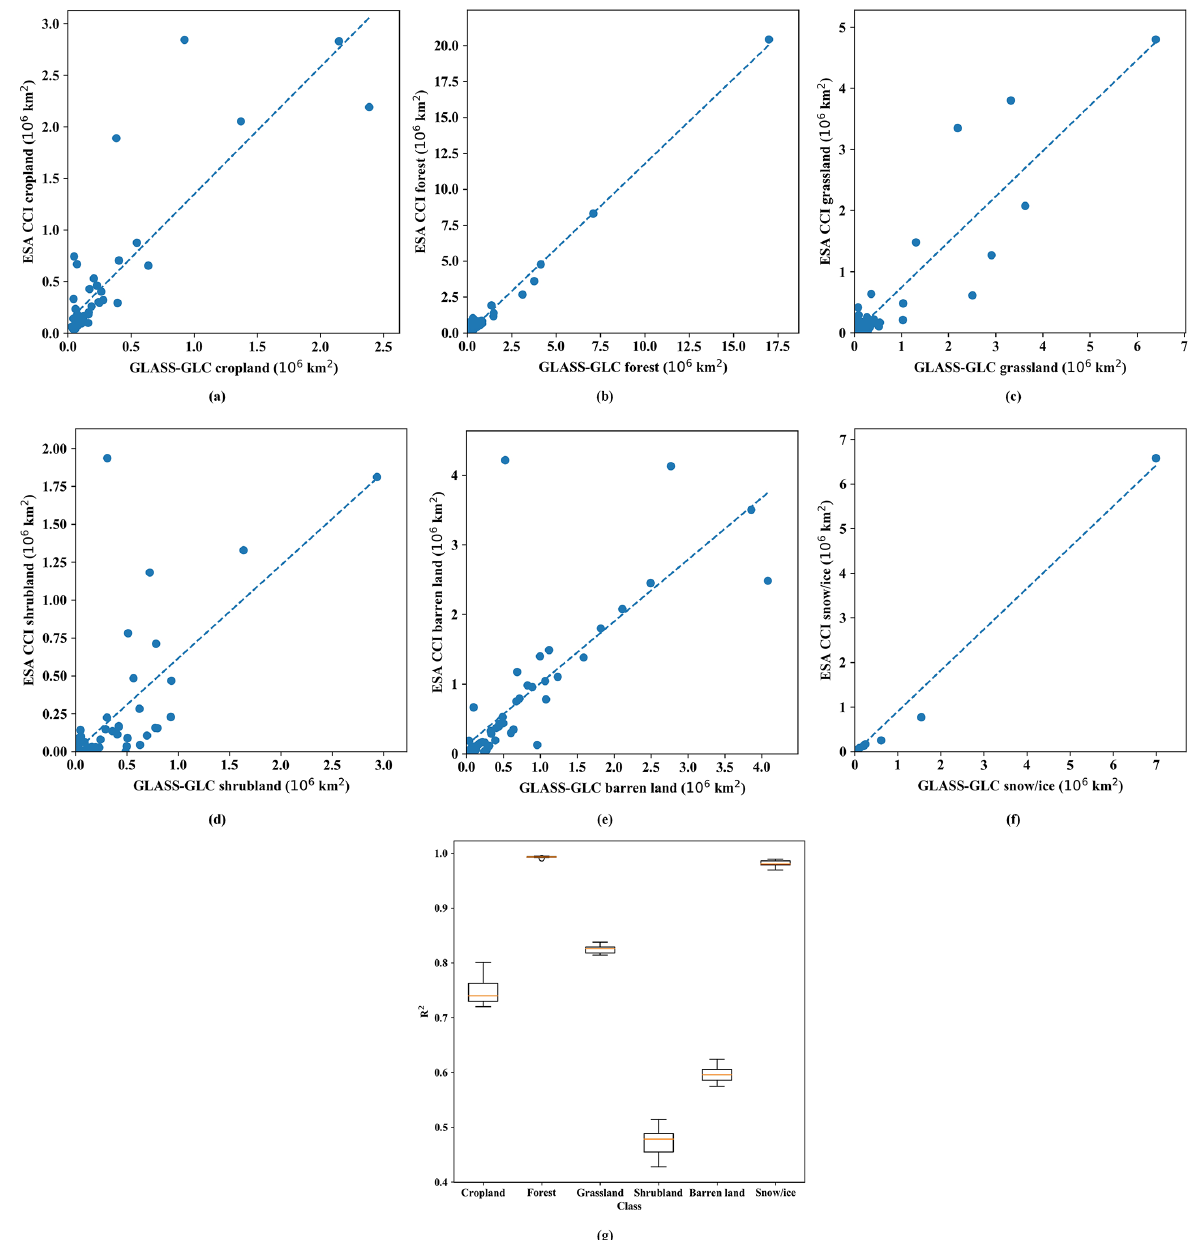
Figure 6. Intercomparison with the ESA-CCI (European Space Agency Climate Change Initiative) land cover product: (a) cropland circa 2015, (b) forest circa 2015, (c) grassland circa 2015, (d) shrubland circa 2015, (e) barren land circa 2015 and (f) snow/ice circa 2015; (g) mean R 2 of the annual linear fit lines for all years